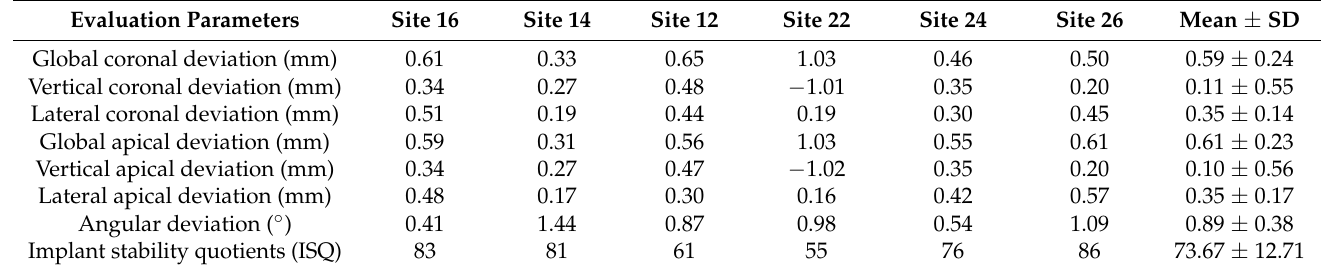
Table 1. Accuracy parameters and implant stability quotients at each implant site.